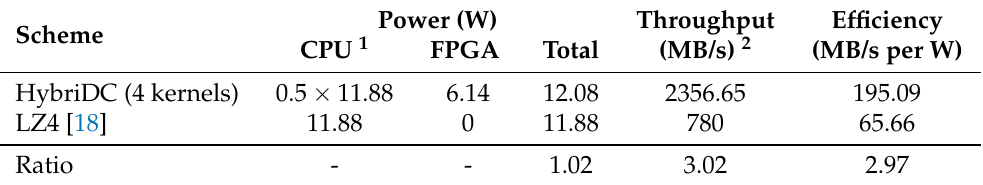
Table 6. The power efficiency comparison between the HybriDC system and LZ4 software.